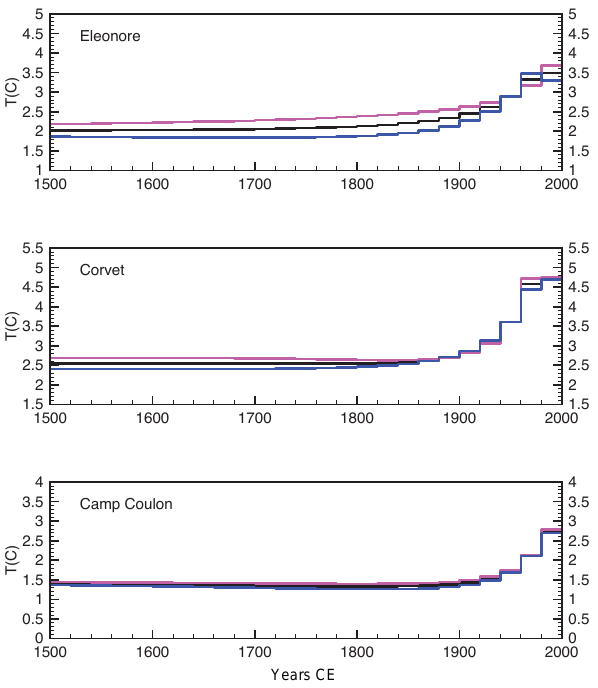
Figure 6. GST histories for the northern Québec sites. Simultane- ous inversion was used for Camp Coulon, which includes more than one hole. The pink and blue lines represent the inversions of the up- per and lower bounds of the